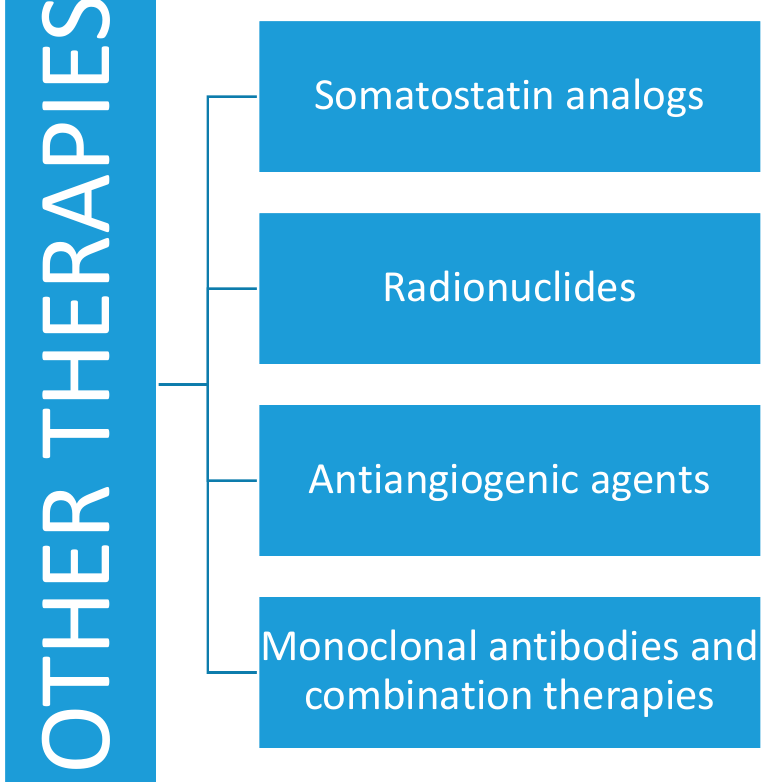
Figure 7. Other therapies in neuroendocrine breast cancer